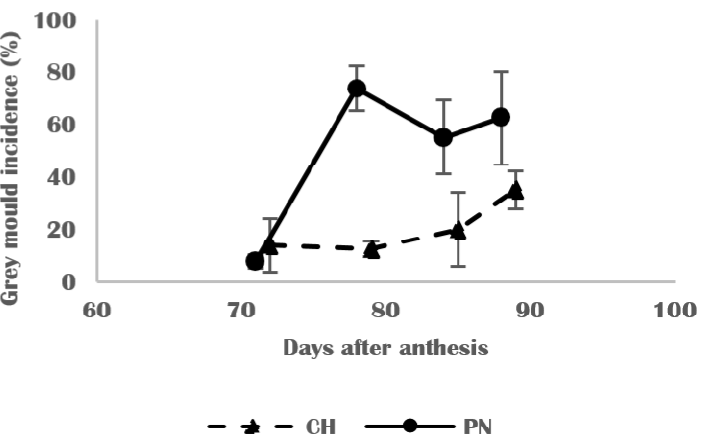
Figure 12. Disease incidence (%) of Pinot noir ( • ) and Chardonnay ( (cid:78) ) grapes during